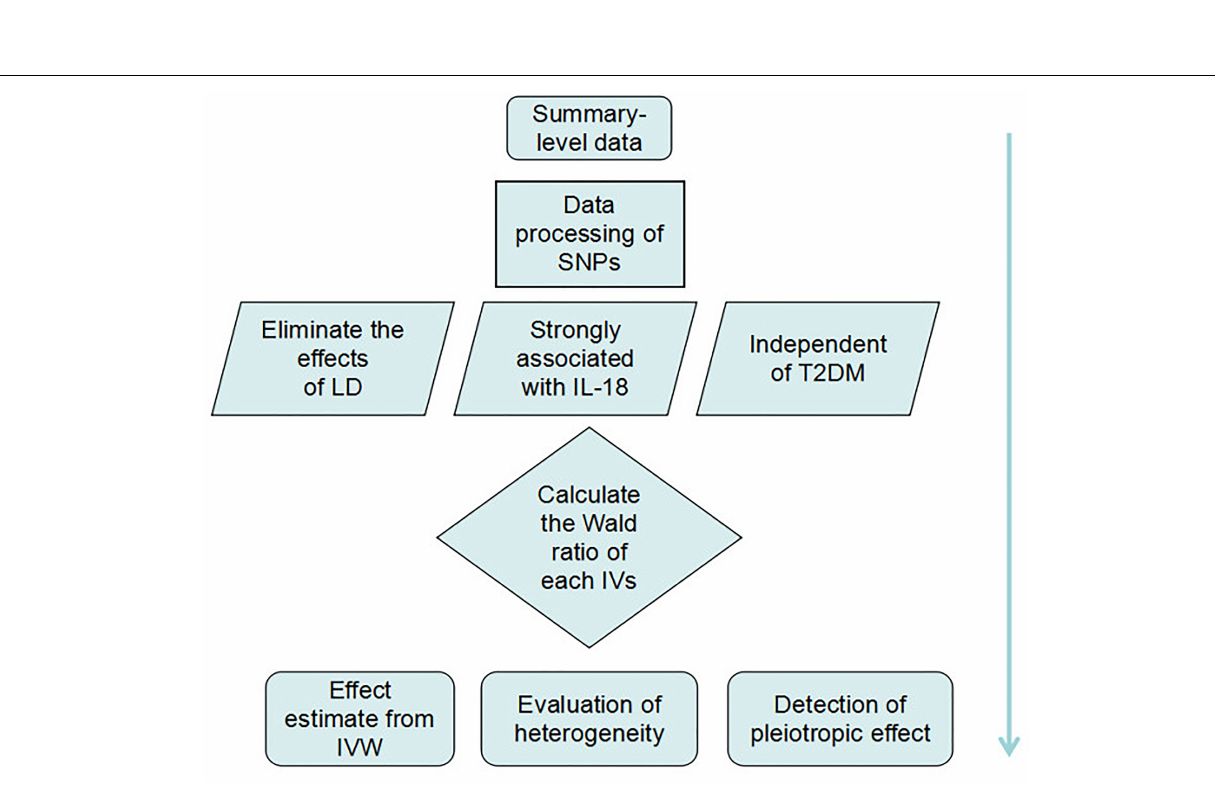
FIGURE 2 | Strategic design of data processing and